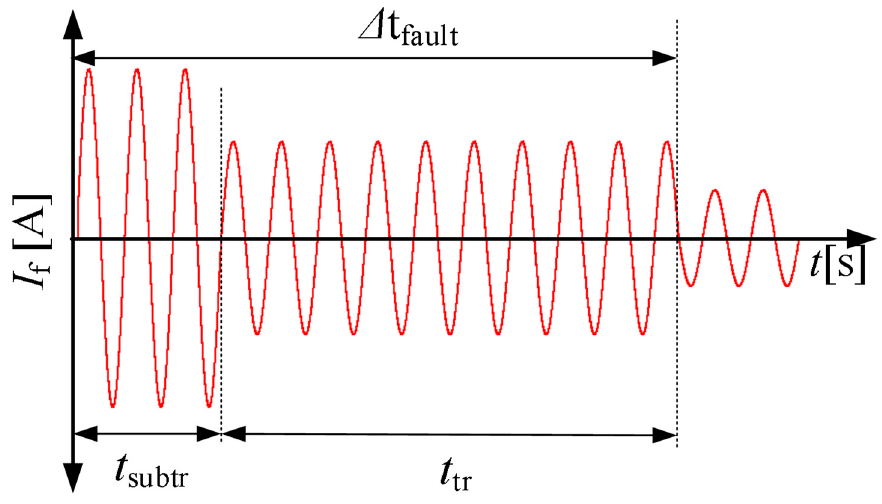
Figure 11. DRES fault current [105].